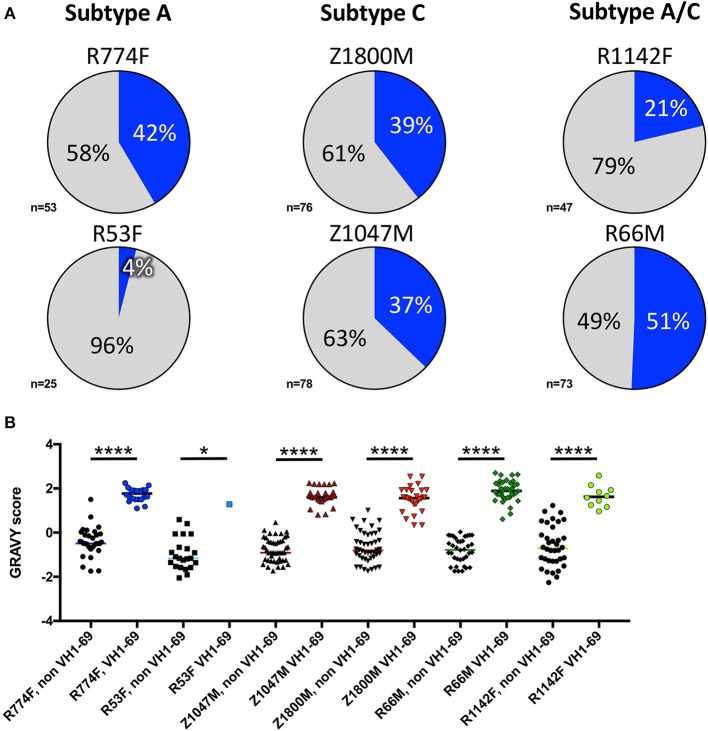
VH1-69 is over-represented among anti-gp120 memory B cells at 7.5-months post-infection. (A) Percentages of VH1-69 germline usage (blue graph sections) vs. all other variable heavy-chain germline genes (gray graph sections) isolated from memory B cells reactive to autologous T/F gp120 in six individuals infected with Subtype A (left column), Subtype C (center column), and Subtype A/C unique recombinants (right column). The total number of heavy chain sequences analyzed for each individual is shown. (B) To determine whether these VH1-69 sequences maintained a hydrophobic complementarity-determining region-2 (CDRH2) associated with VH1-69, grand average hydropathy (GRAVY) scores (Y-axis) were calculated from non-VH1-69 (black symbols) and VH1-69 sequences (colored symbols) obtained from each individual (http://www.gravy-calculator.de), bars represent median values. Individual codes are listed below the X-axis. VH1-69 CDRH2 were significantly more hydrophobic (positive values) than the non-VH1-69 CDRH2 in every individual (Ordinary one-way ANOVA, Tukey's multiple comparisons test: R53F p = 0.018, all others p < 0.0001). Raw values are reported in Supplementary Table 1.